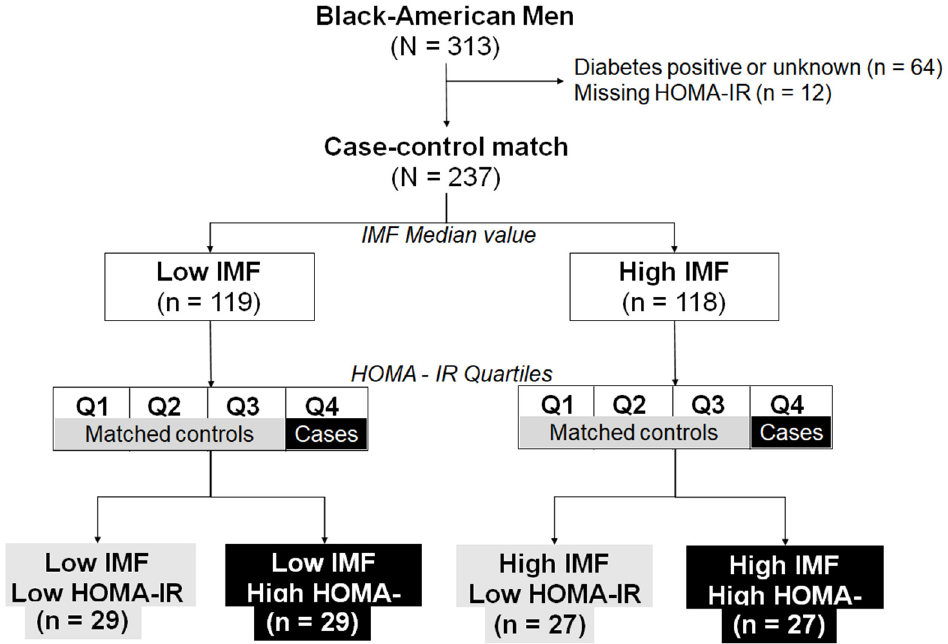
Figure 4. Case-control matching analysis to identify participants with similar levels of IMF but different levels of HOMA-IR. Considering that study participants had the same sex, race, and similar age, matching was performed based on only IMF areas (± 1 cm 2 ; 1:1 allocation ratio). HOMA-IR, Homeostasis Model Assessment of Insulin Resistance; IMF, intermuscular fat area; Q, quartile.